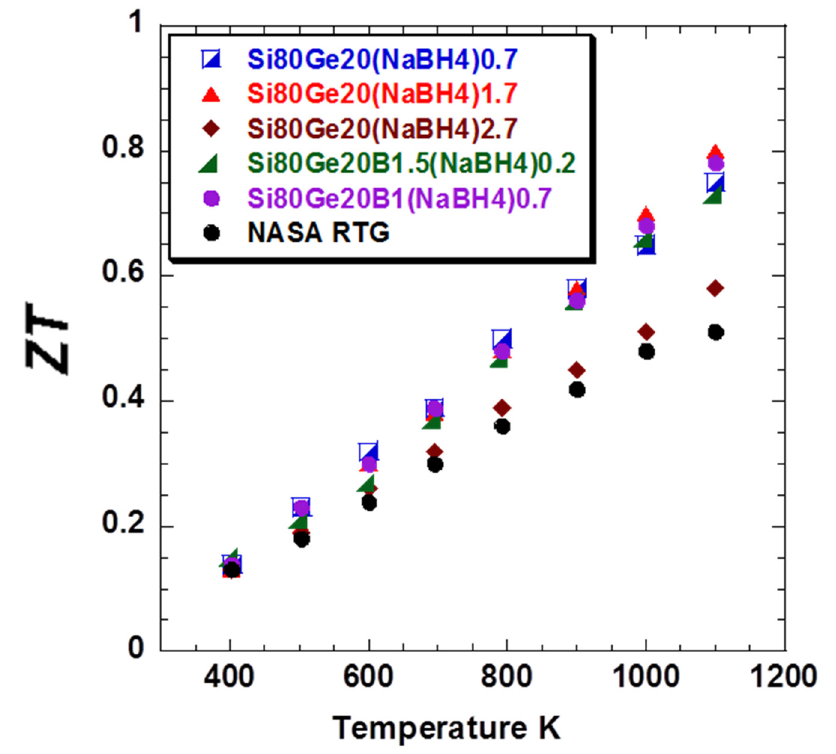
Figure 6. Dimensionless figure of merit ZT of all the samples compared to the p-leg material of NASA’s